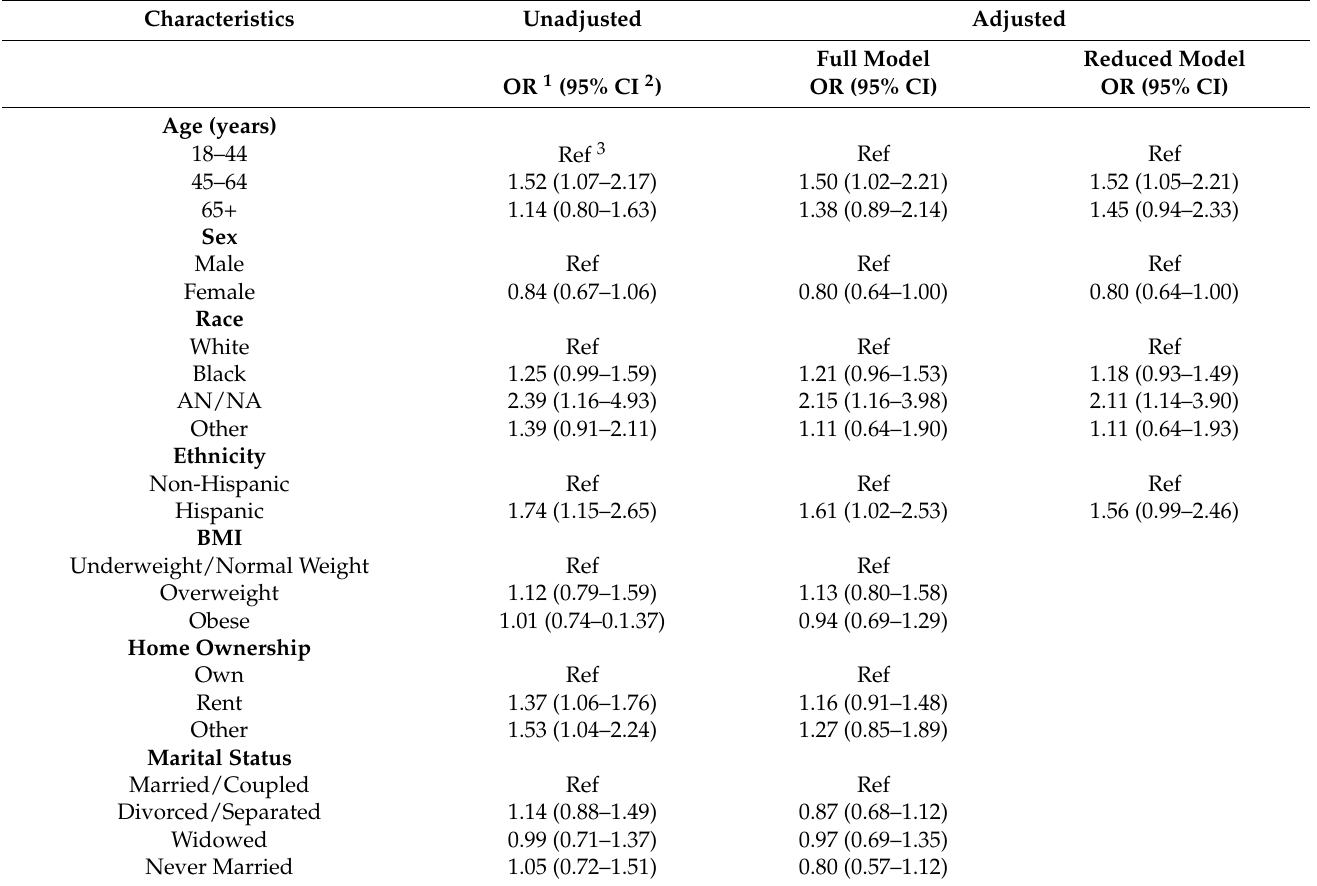
Table 2. Unadjusted and adjusted associations of social determinants of health and diabetic retinopathy.